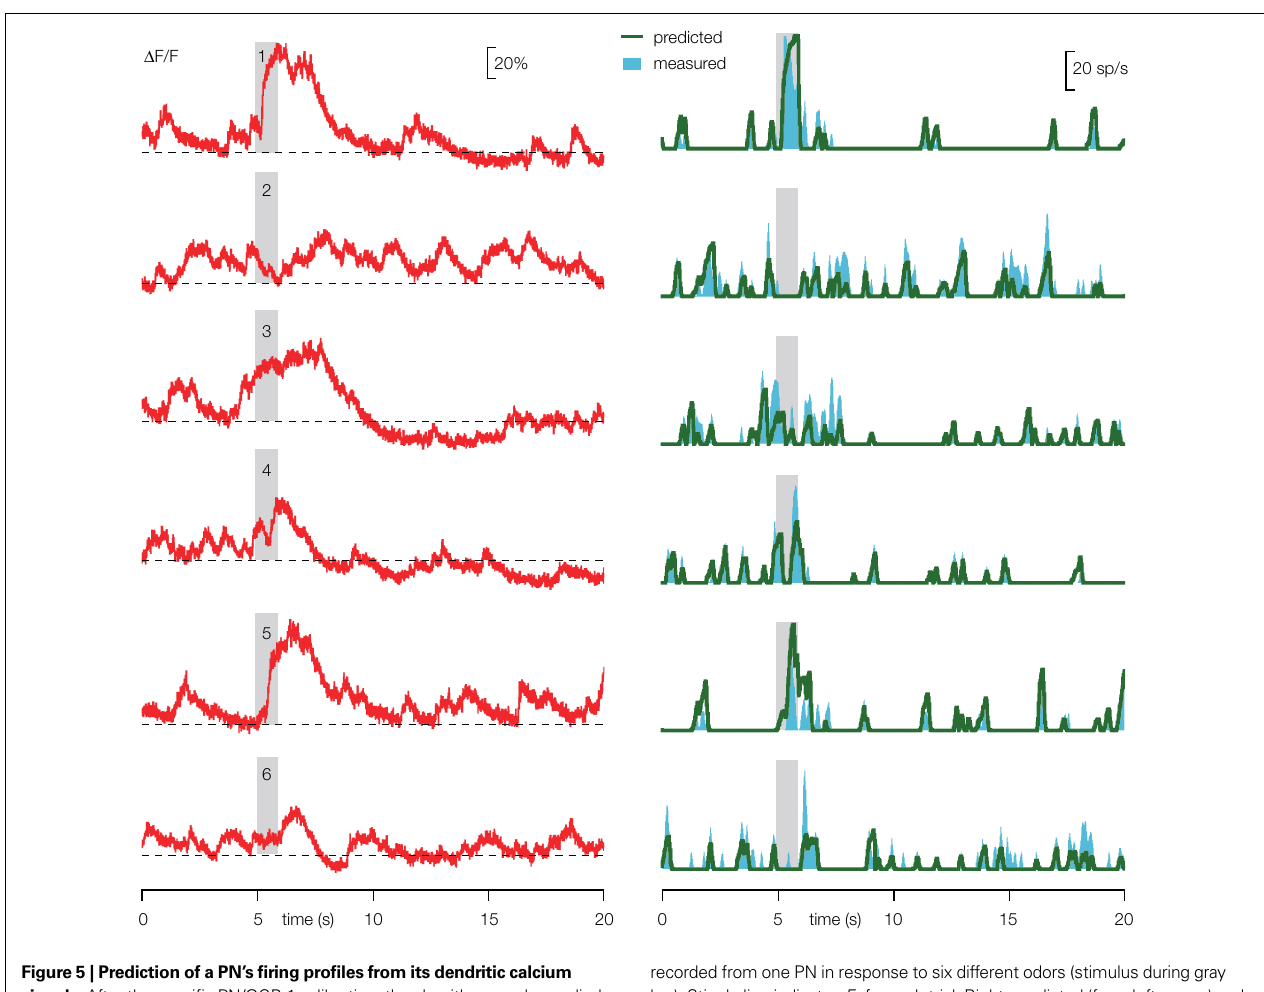
Figure 5 | Prediction of a PN’s fi ring profi les from its dendritic calcium signals. After the specifi c PN/OGB-1 calibration, the algorithm may be applied to single PN-odor calcium imaging alone, baseline F specifi c parameter, as illustrated here. Left: raw fl uorescence traces